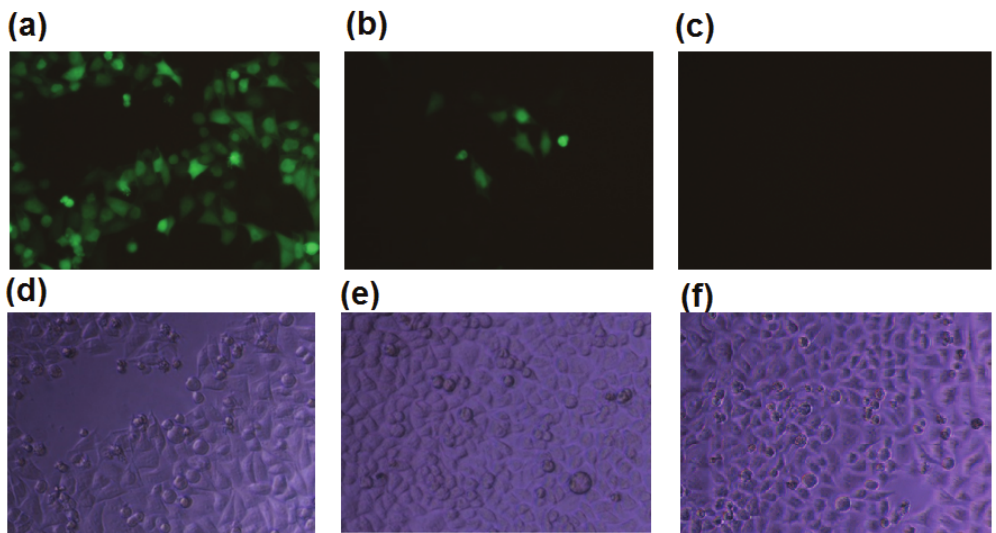
Figure 1. b-AP15 inhibited the proteasome of HeLa ubiquitin-green fluorescent protein (Ub G76V -GFP) cells. HeLa Ub G76V -GFP cells were treated with b-AP15 at 0.95 (cid:2)M ( a , d ); 0.32 (cid:2)M ( b , e ), or no b-AP15 ( c , f ) for 24 h, where ( a ), ( b ), and ( c ) are fluorescence microscopic images; ( d ), ( e ), and ( f ) are regular phase contrast images of the cells.